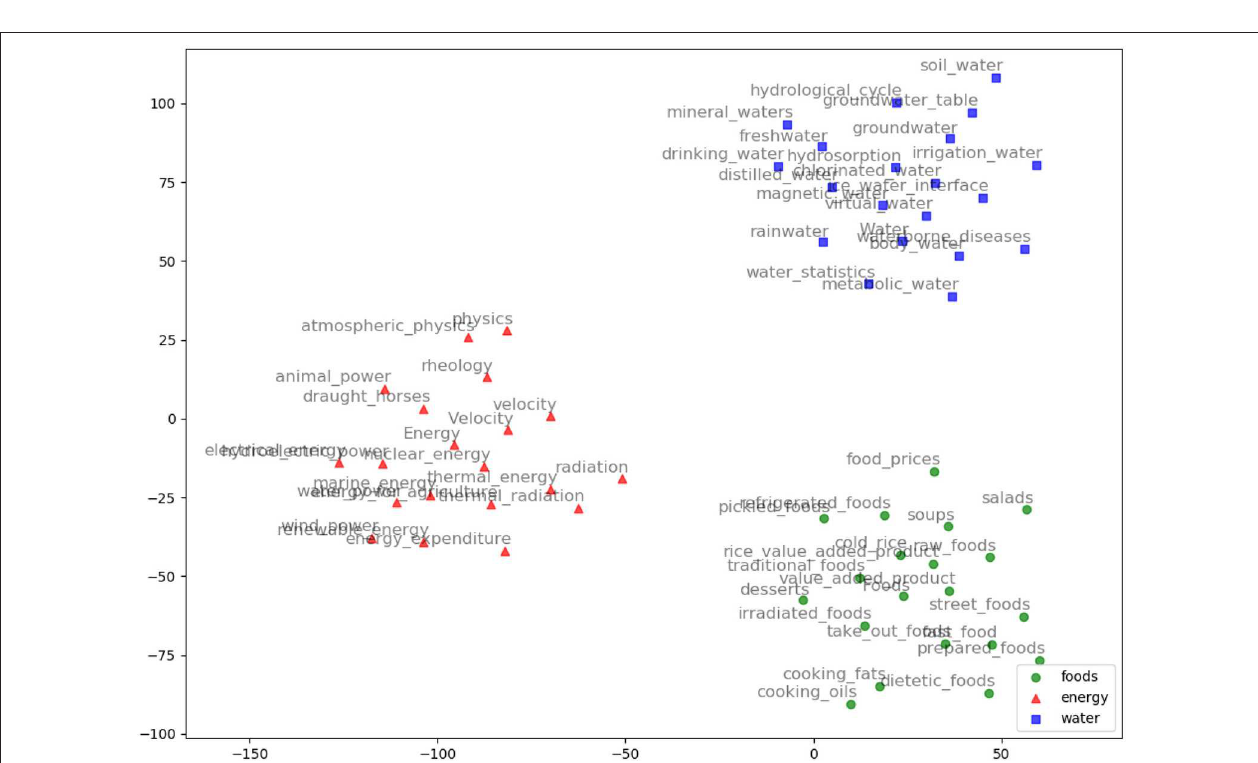
FIGURE 2 | AGROVEC embeddings visualization using TSNE for the words: Food, Energy, and Water with their top 20 nearest neighbors based on AGROVEC model. The figure shows how AGROVEC cluster similar concepts together